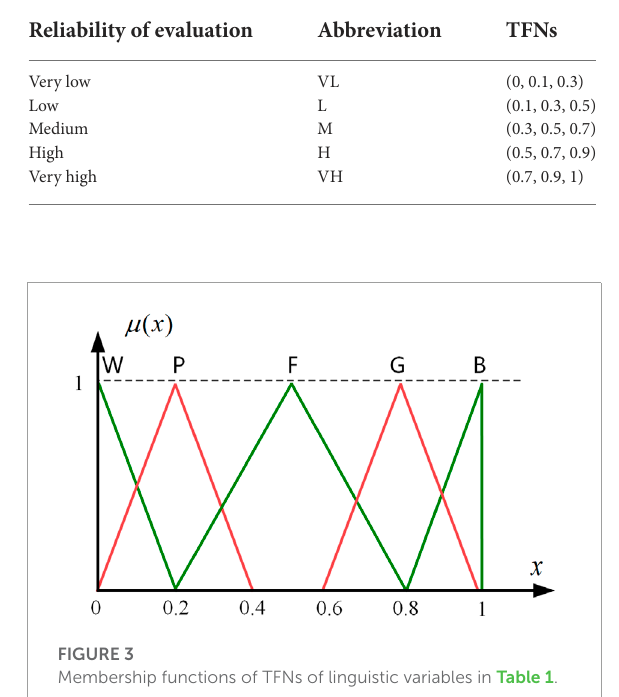
TABLE 2 Linguistic variable for the reliability of evaluation (component B of Z-number).